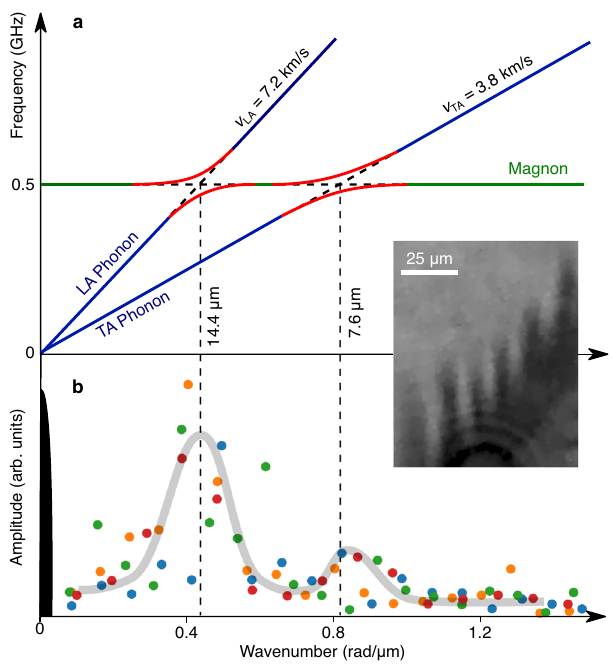
Fig. 3 | Schematic illustration of the self-accumulation process. a Sketch of the anti-crossings (red) between the dispersion relations of the acoustic phonons (blue) and the magnon (green). The group velocities v of the longitudinal acoustic (LA) and transverse acoustic (TA) phonon modes are shown. b Amplitude of the Fouriertransformoftheripplepatternsduringthe fi rst30ns(colouredcircles)and of the pump pulse (black), with a guide to the eye (grey). The blue, orange, green and red points correspond to the Fourier transforms extracted from the magneto- opticalimages taken attimedelays of 1ns, 10ns, 20ns and 30ns, respectively. See the Supplementary Information for the data used in the calculation of the Fourier transforms. Inset: representative zoomed section of the magneto-optical image of the ripple pattern used for the Fourier